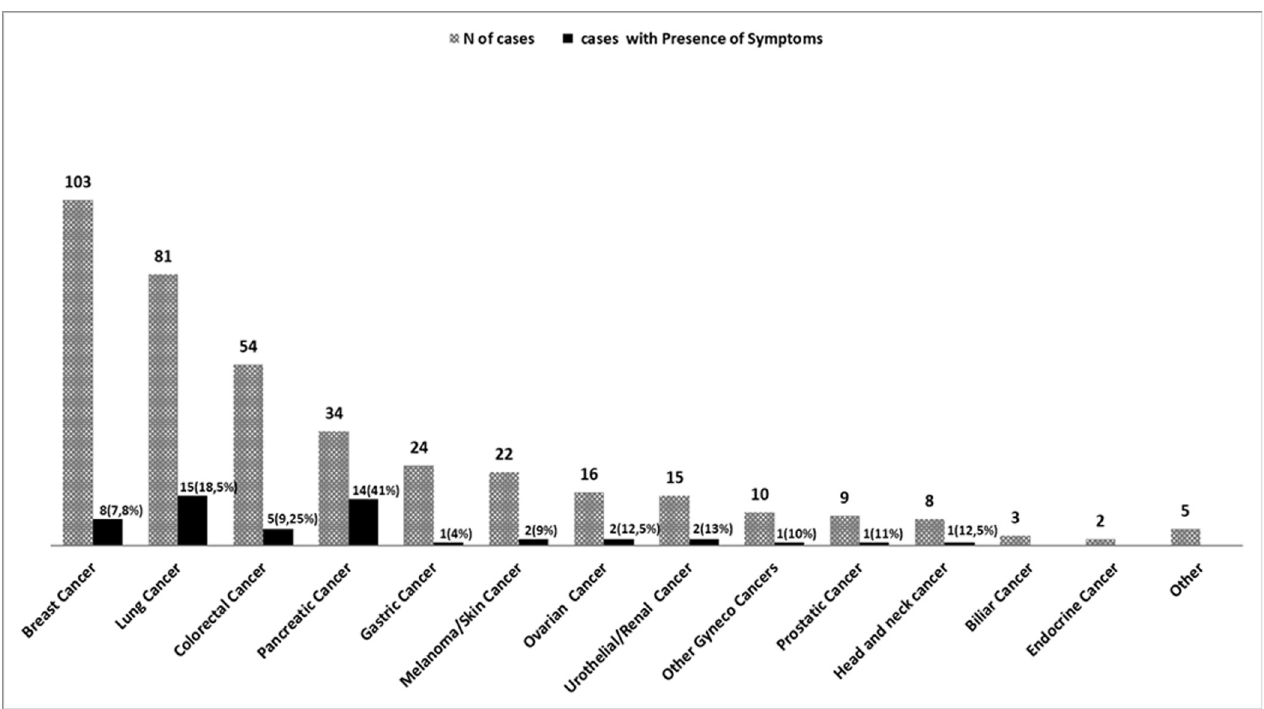
Fig 1. Number of cases according to the solid cancer type and percentage of patients who declared one or more symptoms potentially COVID-19-related at the specific triage procedure.